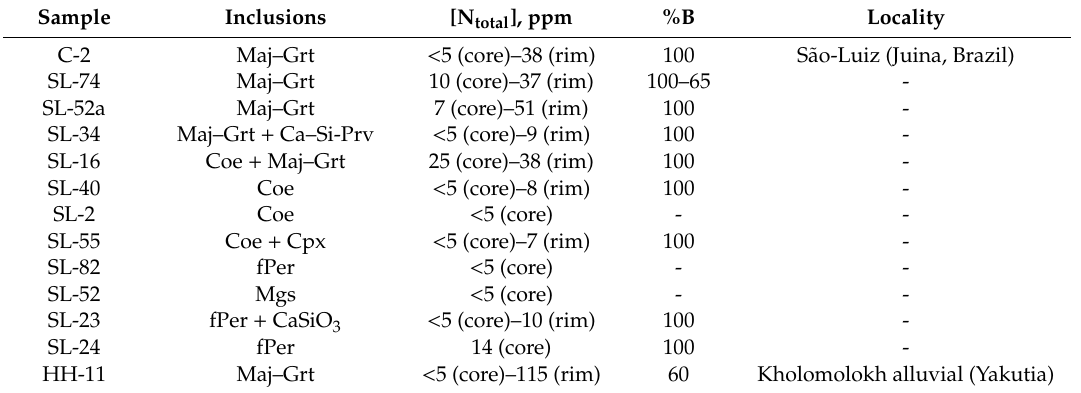
Figure 2. Microphotographs of super-deep diamonds. ( a ) SL-34; ( b ) SL-52; ( c ) SL-55; ( d ) SL-16; ( e ) SL-2; ( f ) SL-24; ( g ) SL-82; ( h ) SL-74; ( i ) HH-11. (a–h) super-deep diamonds from São-Luiz alluvial placers (Juina, Brazil); (i) super-deep diamond crystal from Kholomolokh placer (Yakutia, Russia). Table 1. Sample description.